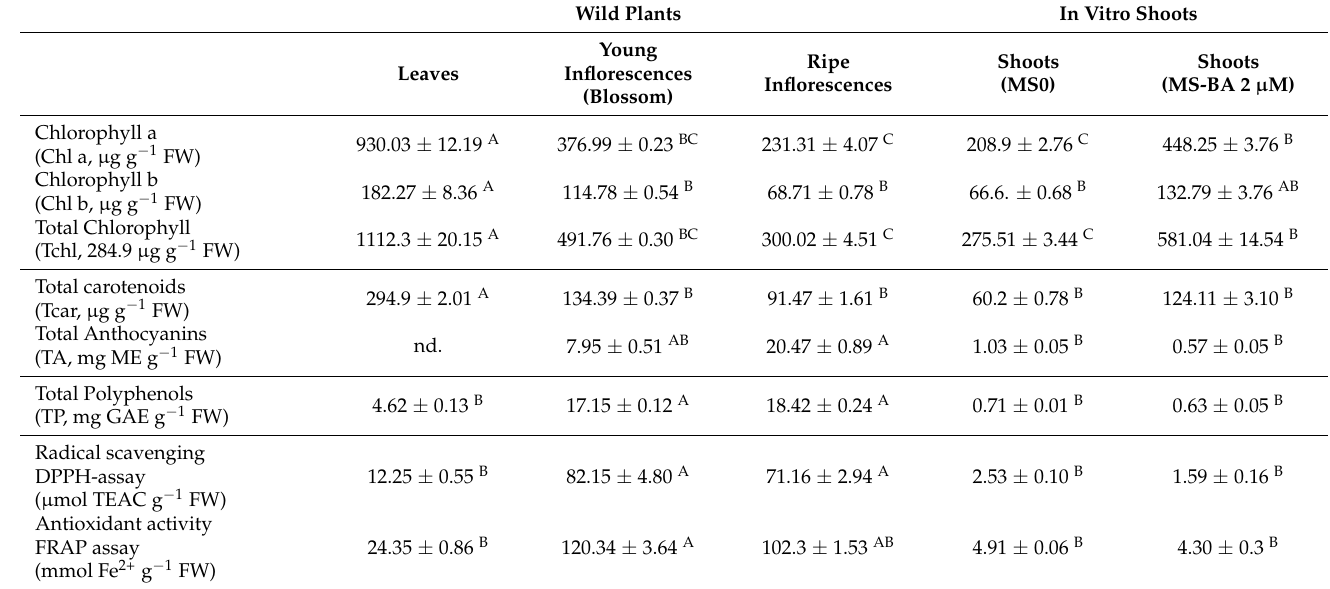
Table 2. Determination of metabolites in the different A. caerulescens organs grown in a wild area or in an in vitro culture. Data are presented as means ± SE ( n = 5). Different letters indicate statistically significant differences determined by Tukey’s b post hoc test ( p < 0.05). Abbreviations: nd.—not